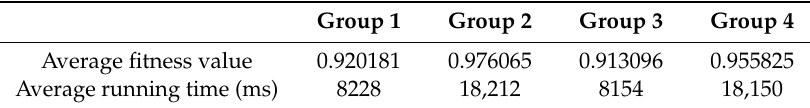
Figure 6. Experimental results of running 20 times. Table 15. Simulation test results.